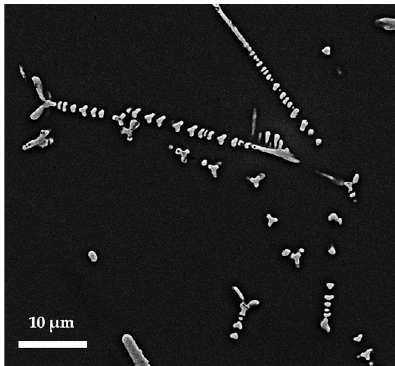
Figure 16. FEG–SEM micrographs cuprite crystal in sample R9 (Gr-4).